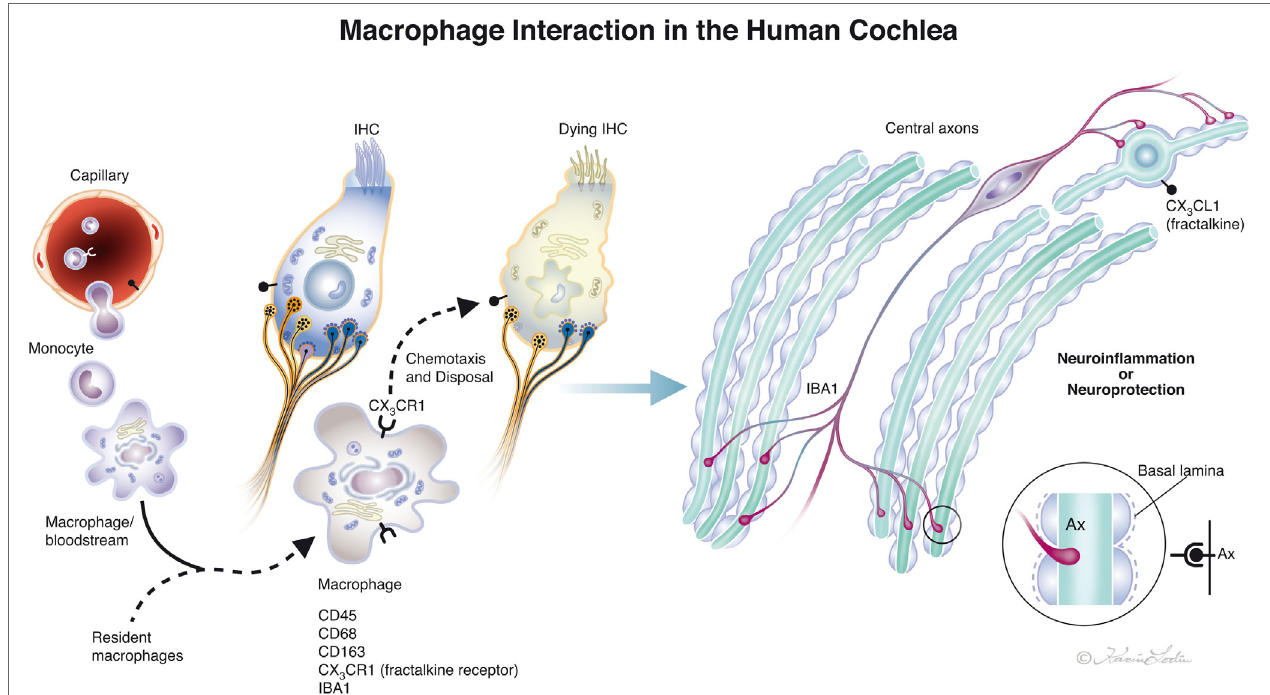
FigUre 10 | Drawing showing possible macrophage interaction in the human cochlea. Macrophages [ionized calcium-binding adaptor molecule 1 (IBA1) cells] can be observed in the human cochlea, both in the spiral ganglion and more seldom in the organ of corti. Macrophages may interact to form a protective link between hair cells and neurons via a fractalkine/CX3CR1 signaling system as demonstrated experimentally by Kaur et al. (23) (illustration by Karin